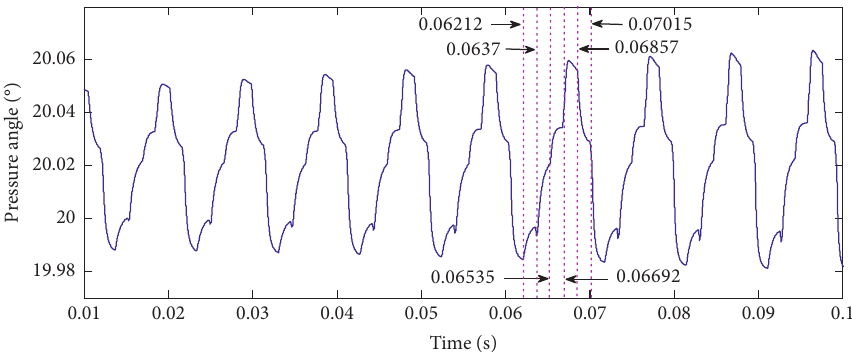
Figure 11: Time-varying pressure angle of s- p